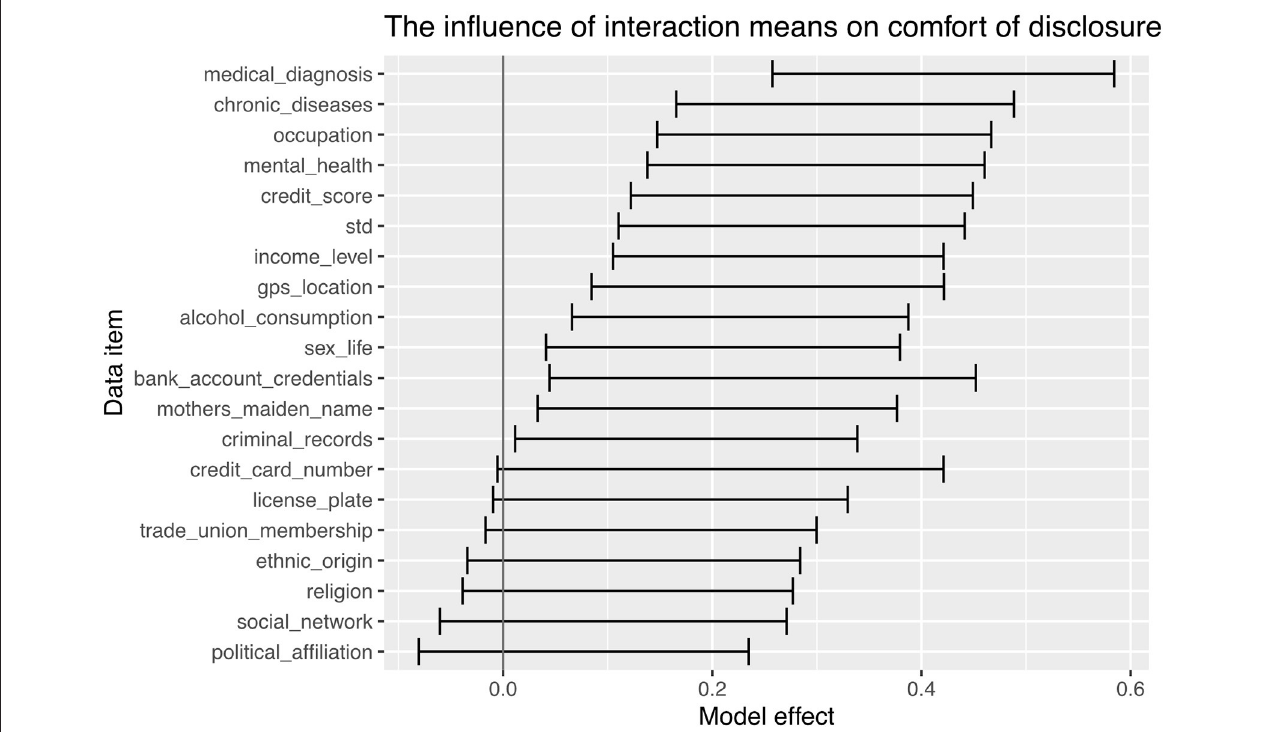
FIGURE 7 | The influence of interacting with a human or chatbot on comfort of